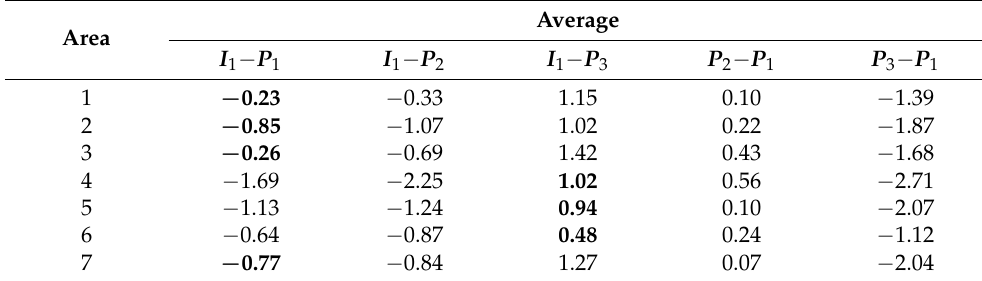
Table 2. Mean value of height difference using UAV data.